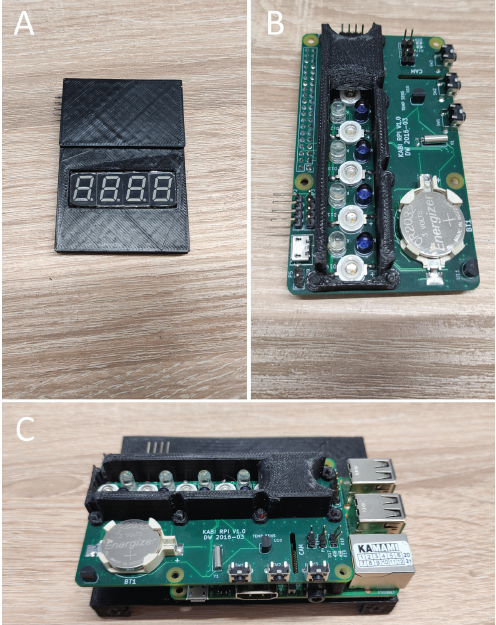
Figure 2. Internal parts of the acquisition device: ( A ) 7-segment module with its driver and in the 3D printed case; ( B ) our designed and fabricated module with NIR LEDs; ( C ) the NIR LEDs module on top of the Raspberry